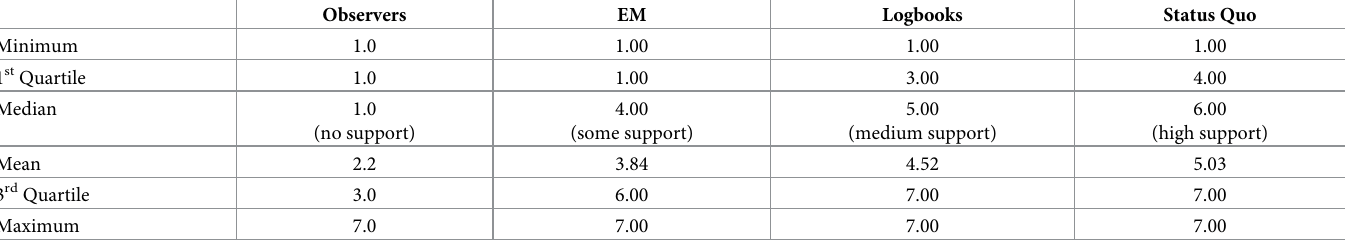
Table 2. Summary of basic rankings across four alternatives for data collection (n = 75) across human observers (‘Observers’), electronic monitoring (‘EM’), detailed logbooks (‘Logbooks’), and the status quo (‘Status Quo’) alternatives for data collection at sea. Observers